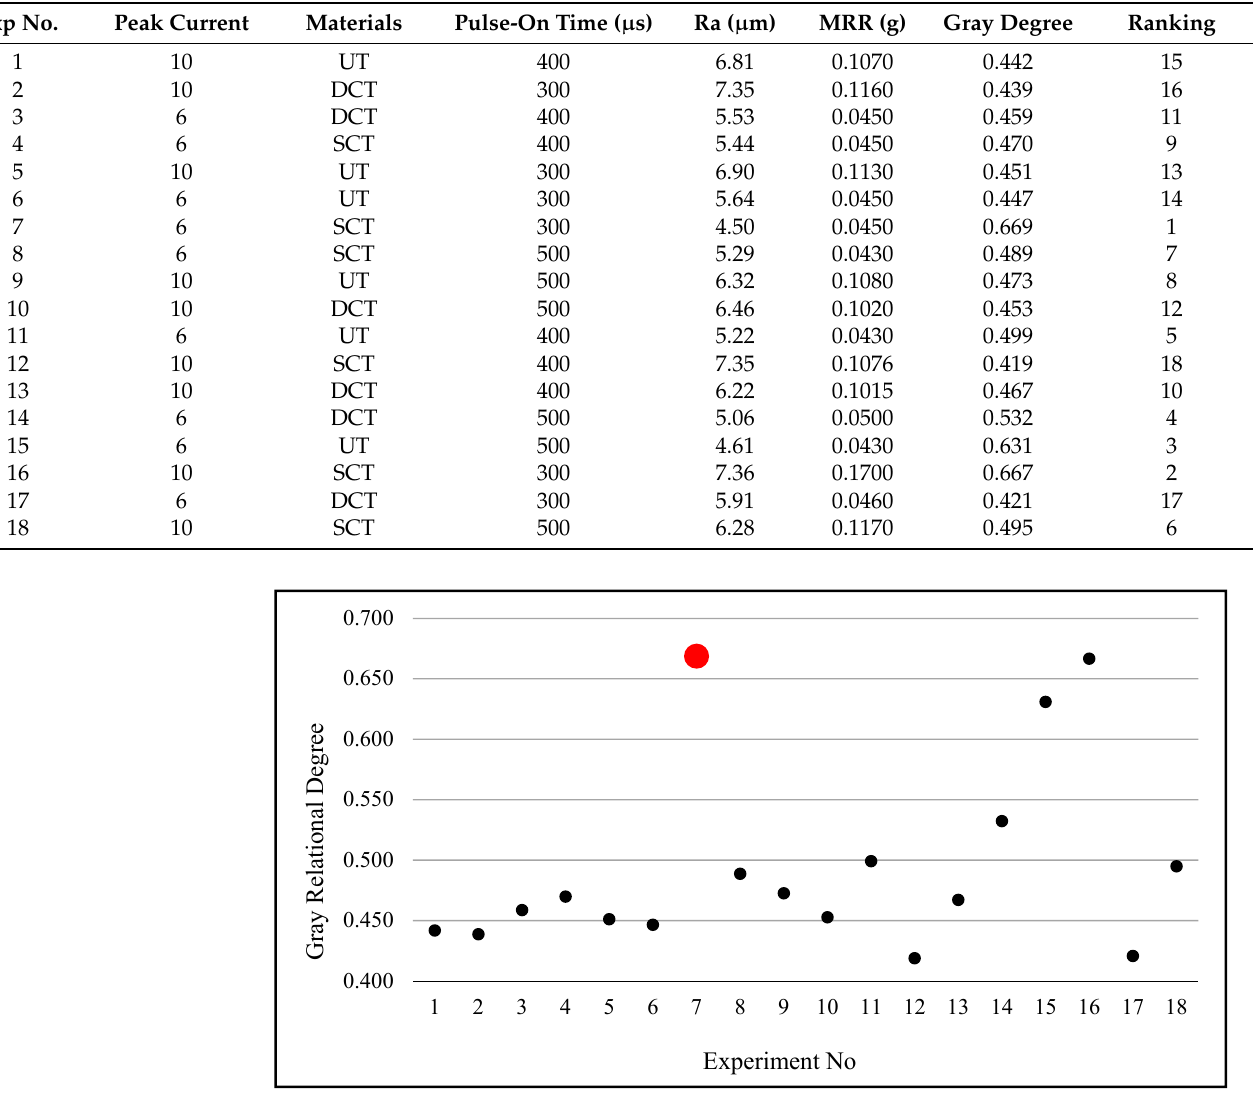
Figure 12. Gray correlation level for lowest average surface roughness and highest MRR.